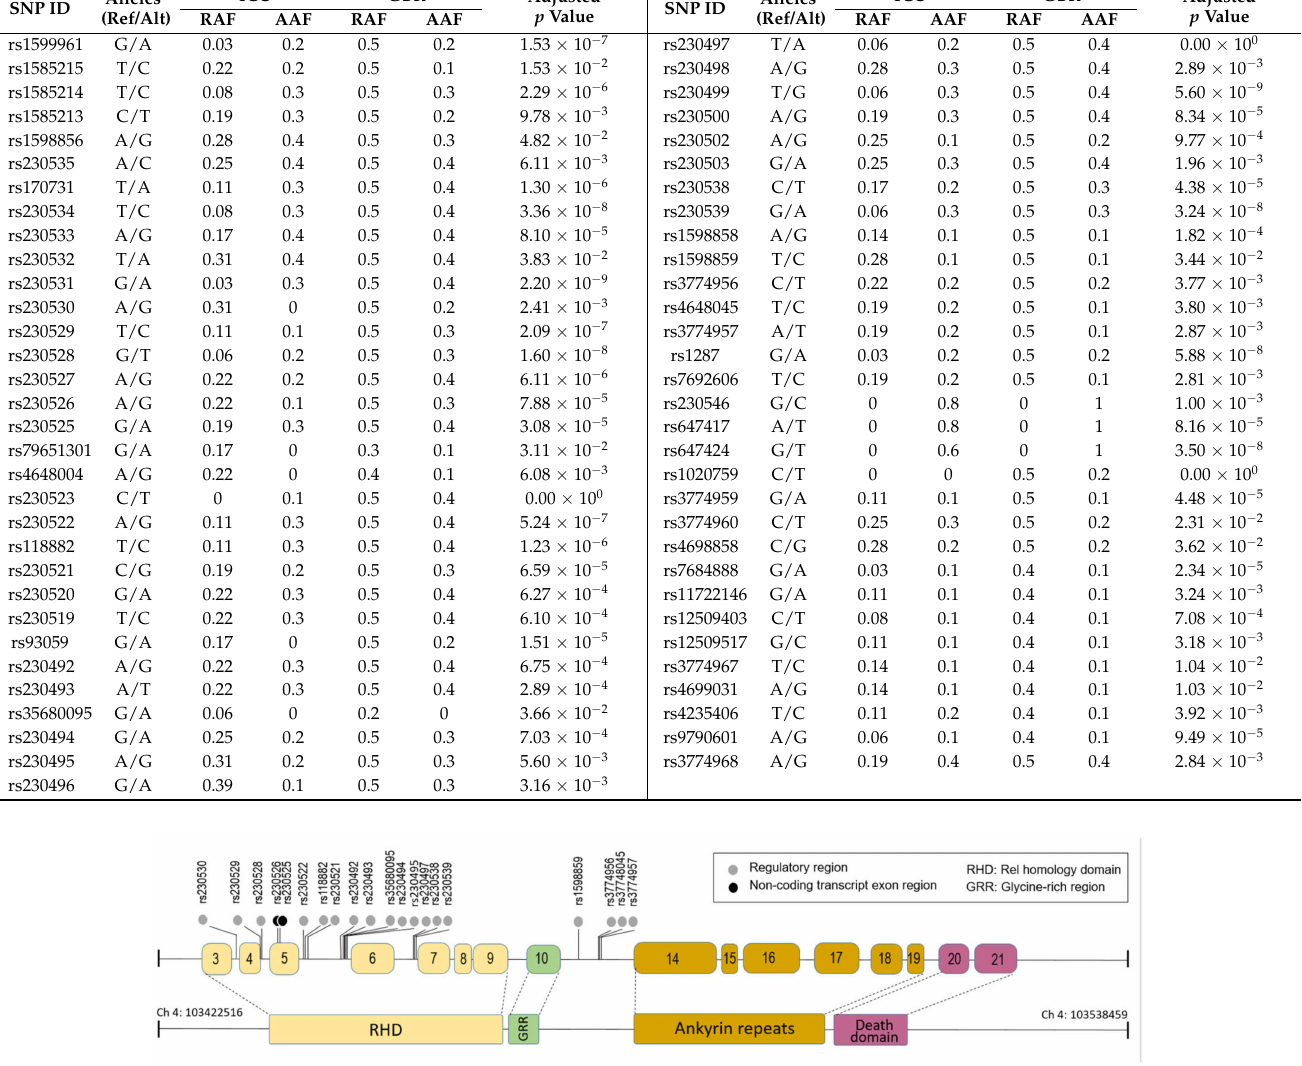
Table 3. Associations of NFKB1 genotype frequencies with risk of severe AH1N1 pdm09 infection.